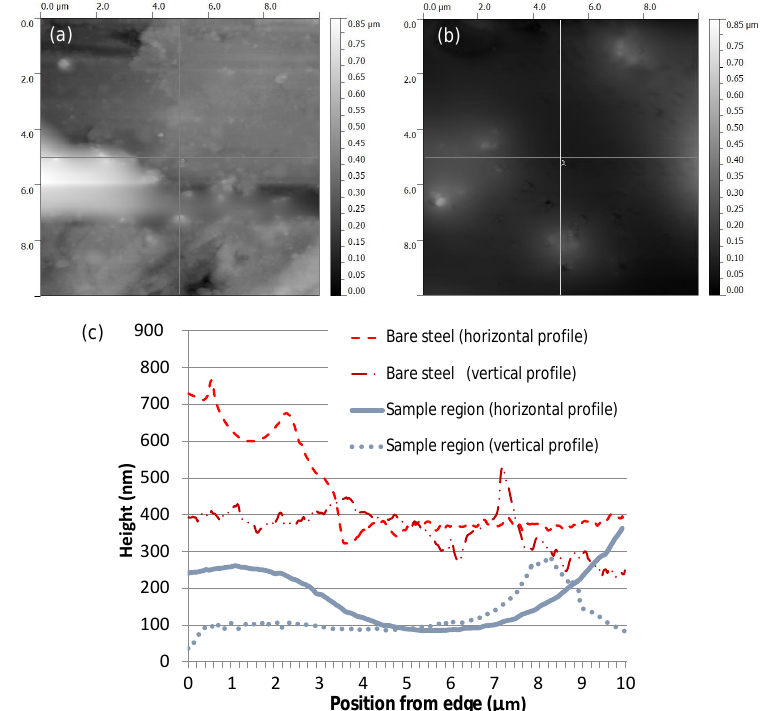
Figure 2. Panel (a) shows an AFM surface scan of cleaned (no sample) puck. The surface is rough at this microscopic level. Panel (b) shows an AFM scan of the same puck after sampling. This image was collected in the sample deposit region. It shows that the roughness gets filled in by the sample. Panel (c) shows the centered vertical and horizontal traces from these analyses. Significant roughness is observed on the steel that is not observed on the collected sample. This indicates that the sample could flow; i.e., it had liquid characteristics at the time of